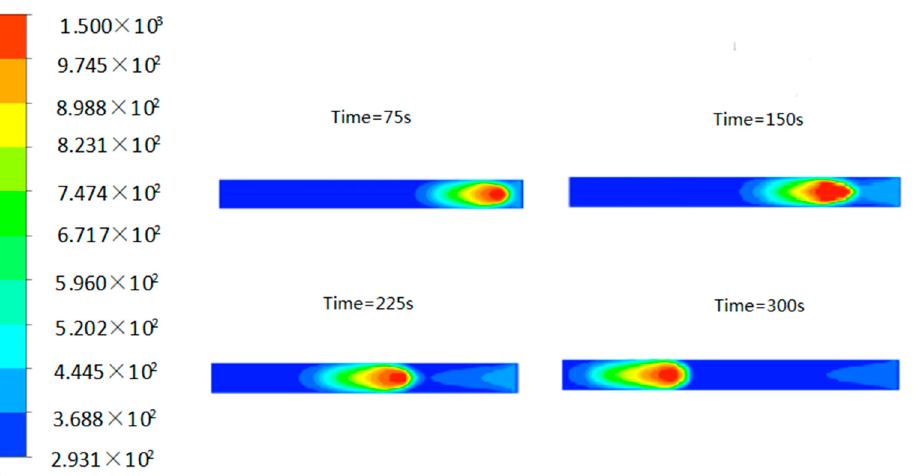
Figure 2. Temperature field of the tobacco area at different times.